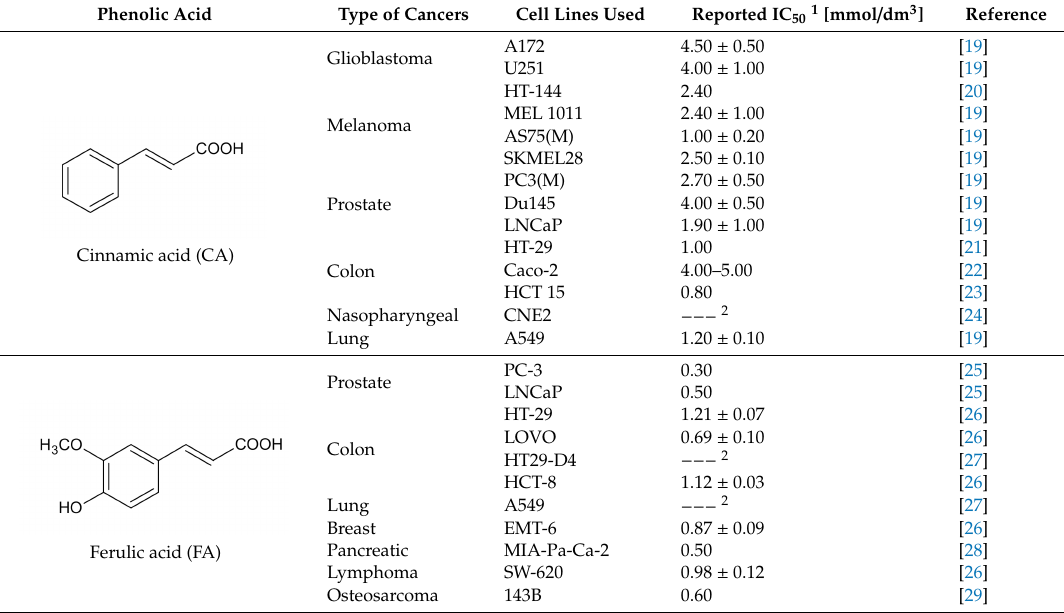
Table 1. Reported anti-cancer activities of cinnamic and ferulic